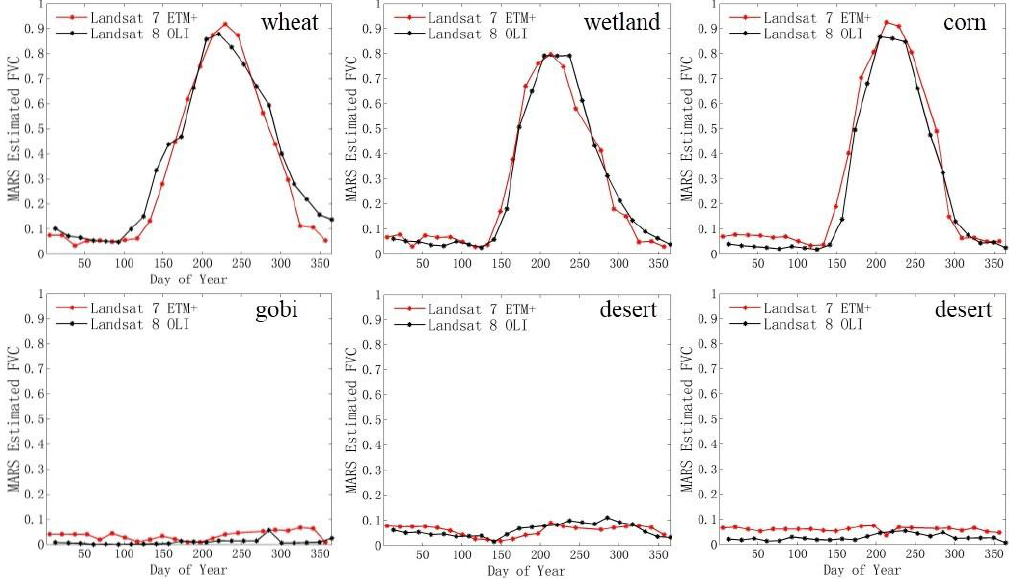
Figure 12. Temporal dynamics of the Landsat 7 ETM+ and Landsat 8 OLI FVC estimates within six representative vegetation types in the Heihe River area. representative vegetation types in the Heihe River